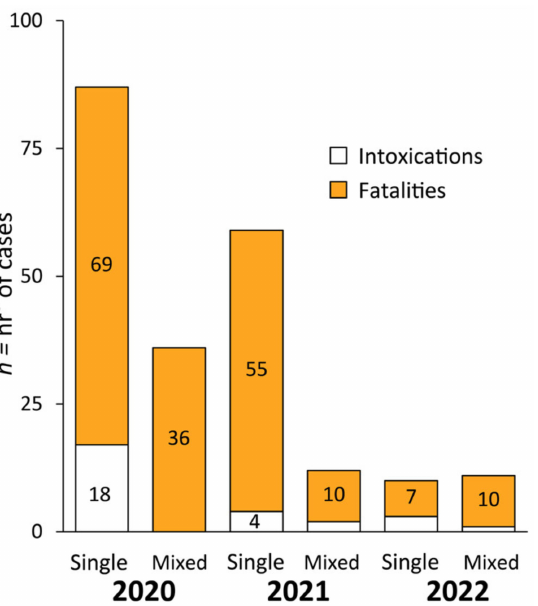
Figure 2. Number of single- and mixed-NPS intoxications and fatalities during the pandemic